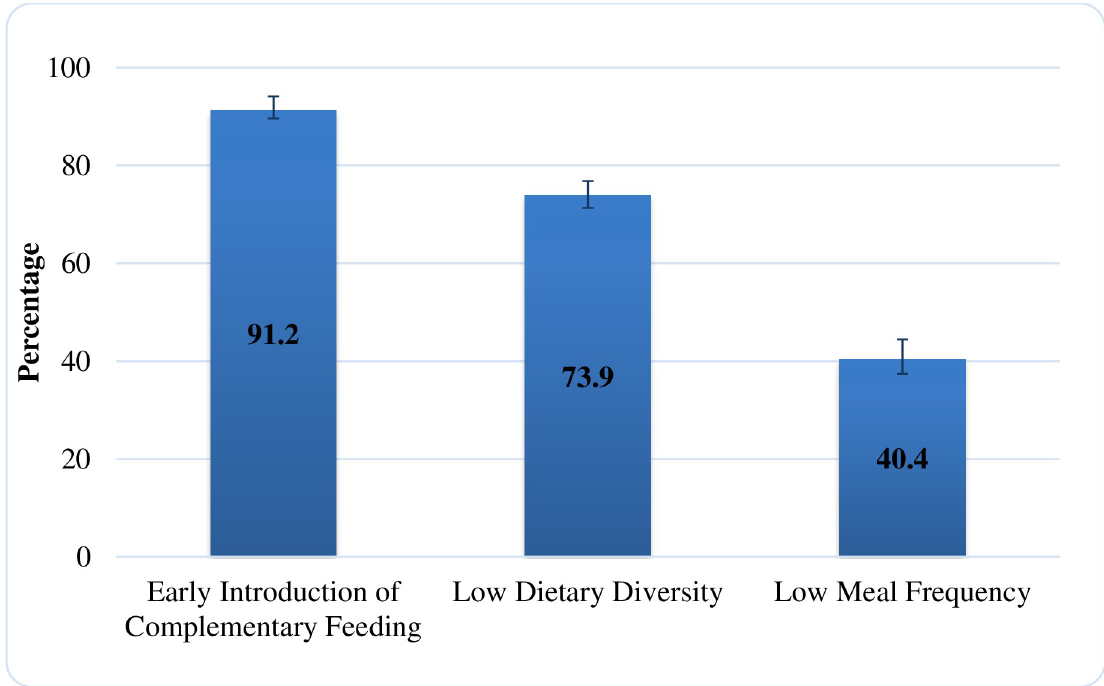
Fig 4. Proportion of inappropriate complementary feeding practices among children aged 6–24 months.